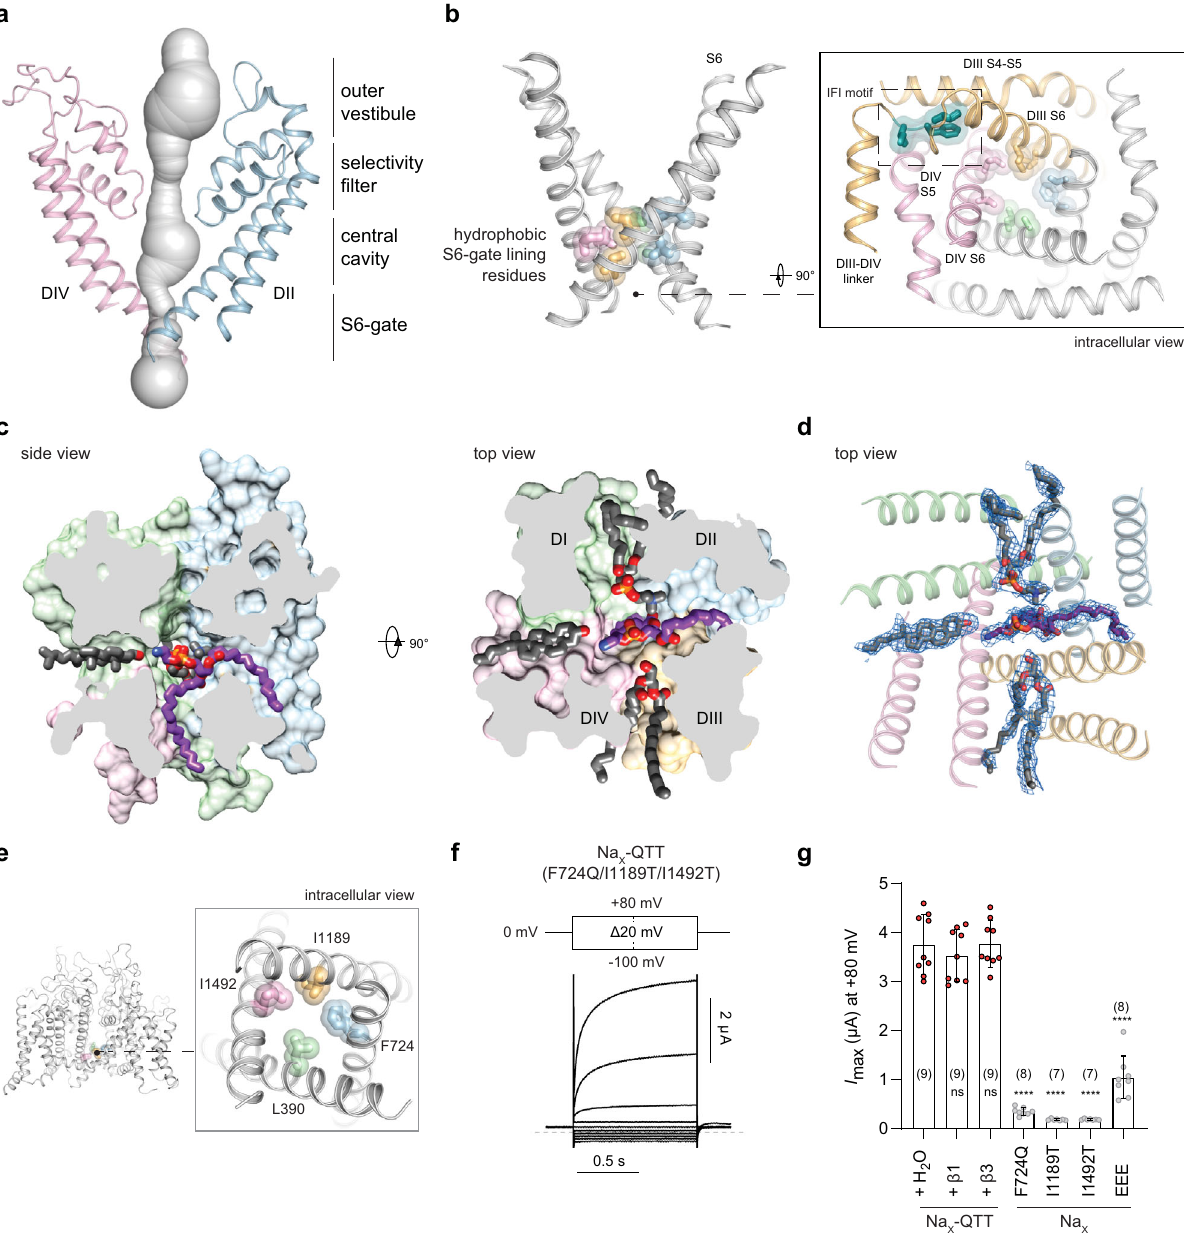
Fig. 2 Na X pore module structure reveals a nonconductive state. a Na X pore volume shown as gray surface with DII and DIV in cartoon rendering (DI and DIII omitted for clarity). b View of the S6-helices with side-chains lining the activation gate shown. Orthogonal view provides a wider perspective with DIII and DIV colored orange and pink, and the IFI-motif (green) from the DIII – DIV linker shown in stick and semi-transparent surface representation. c Orthogonal views sliced through the pore module highlighting lateral fenestrations and bound lipids. The phosphatidylethanolamine that crosses the S6-gate is in purple stick representation. d Similar to middle panel c , but with cryo-EM map shown in blue mesh representation. e Location of S6-gate hydrophobic side-chains targeted by pore-wetting mutations. f Representative currents from Xenopus laevis oocytes expressing the Na X -QTT construct with voltage protocol indicated. g Data summary of independent experiments with indicated constructs (see Supplementary Fig. 8). Data are shown as mean ± SD; ns not signi fi cant; **** p < 0.0001; one-way ANOVA with Dunnett ’ s test (against Na X -QTT + H 2 O). Exact p -values and statistical parameters are provided in Source Data. Numbers of biological replicates ( n ) are